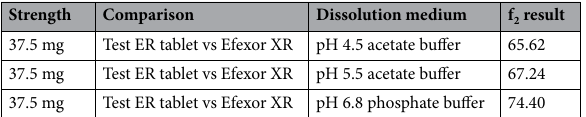
Table 10. f 2 data of in-house produced VEN ER tablet and Efexor XR.